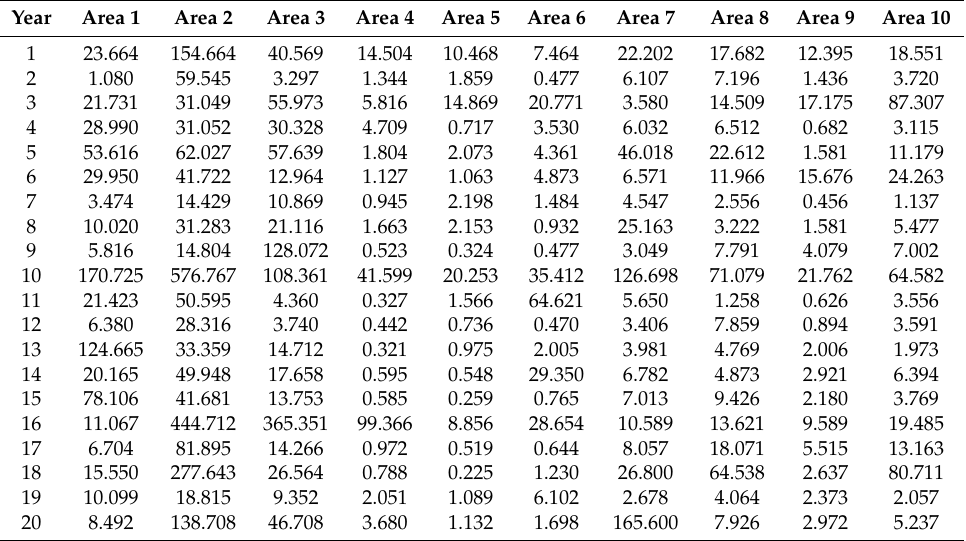
Table 11. Insurance losses in Example 5, part I.